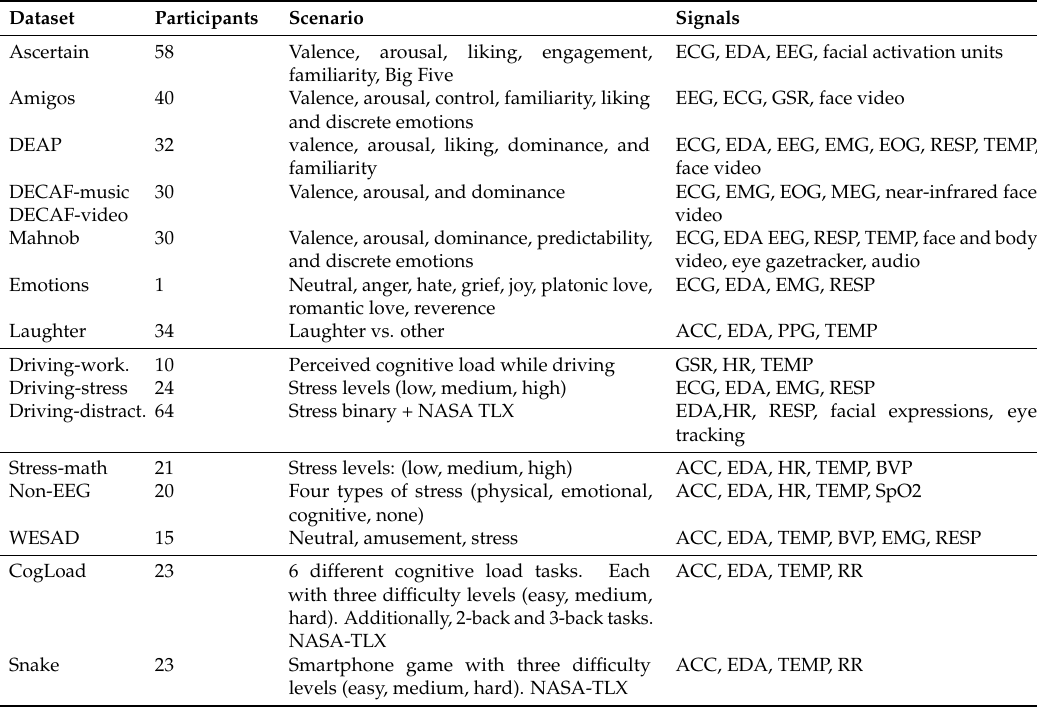
Table 1. Publicly available datasets from related